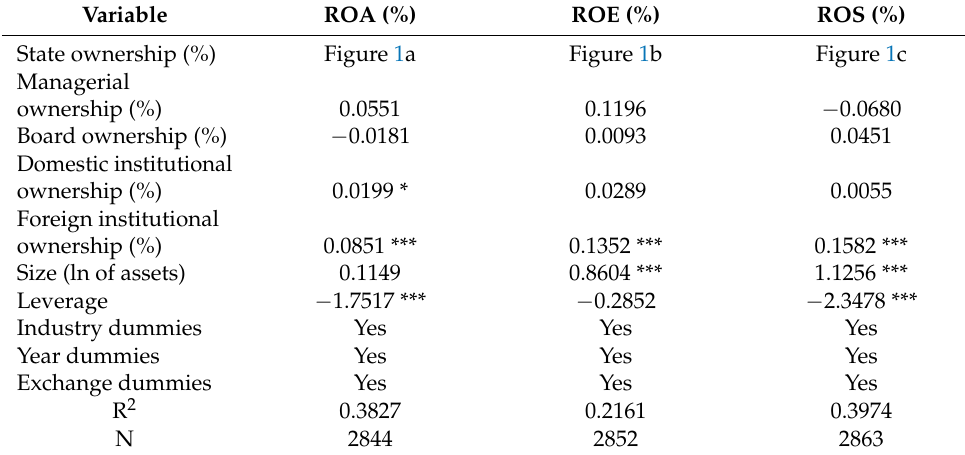
Table 2. Semiparametric regression models of partially privatized firm profitability on residual state